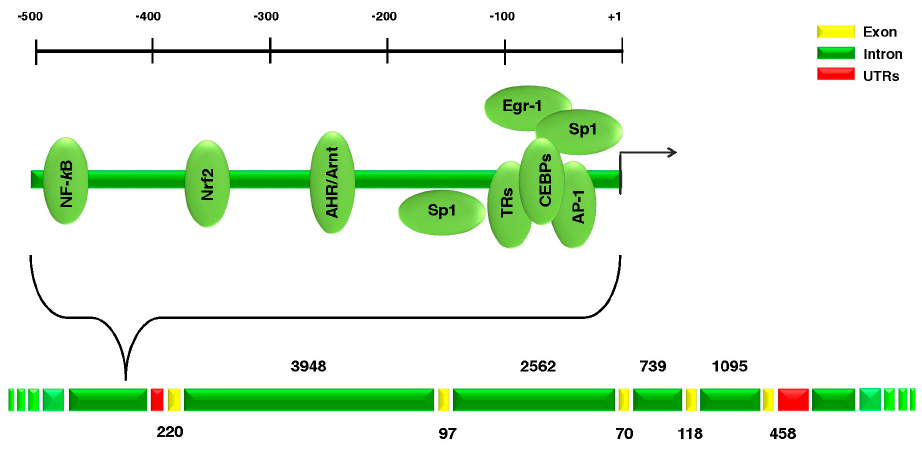
Figure 1. Structure of the SOD1 gene.